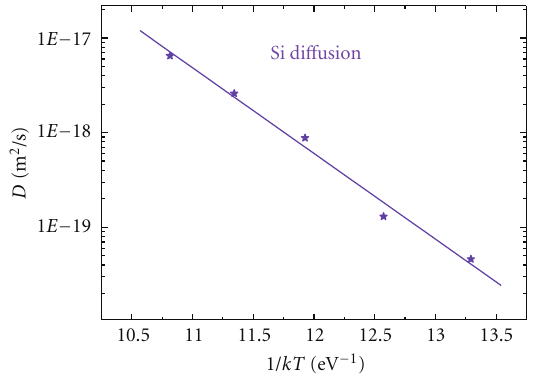
Figure 7: Arrhenius plot for the determination of activation energy for Si di ff usion in D9